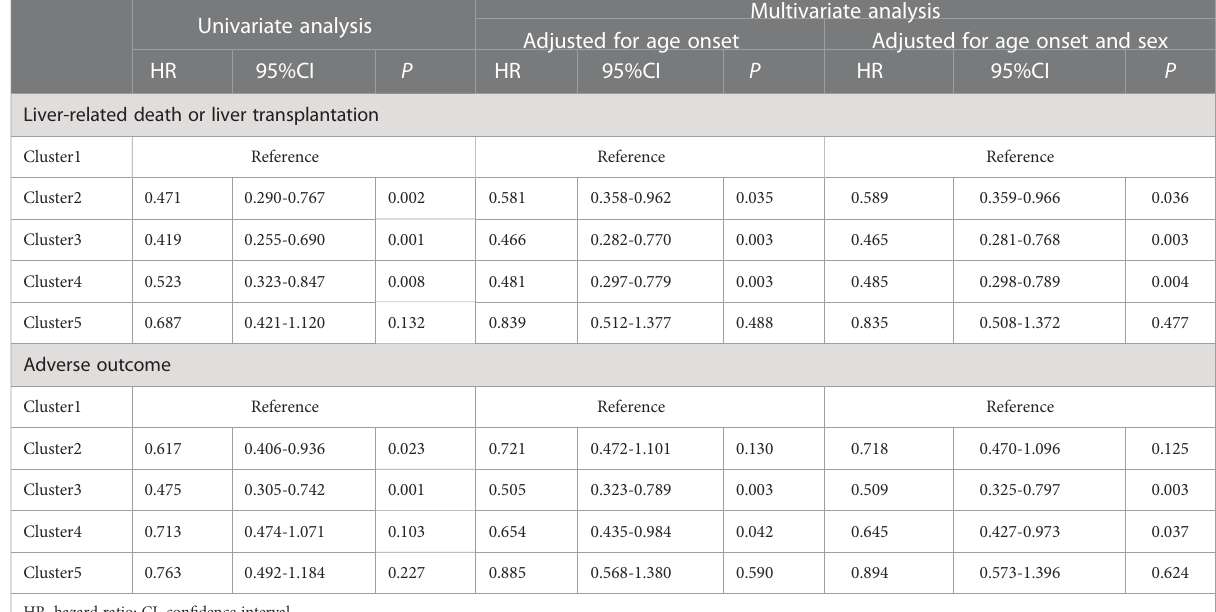
TABLE 4 Cox regression analyses of liver-related death or liver transplantation, and adverse outcome between autoantibody clusters of patients with